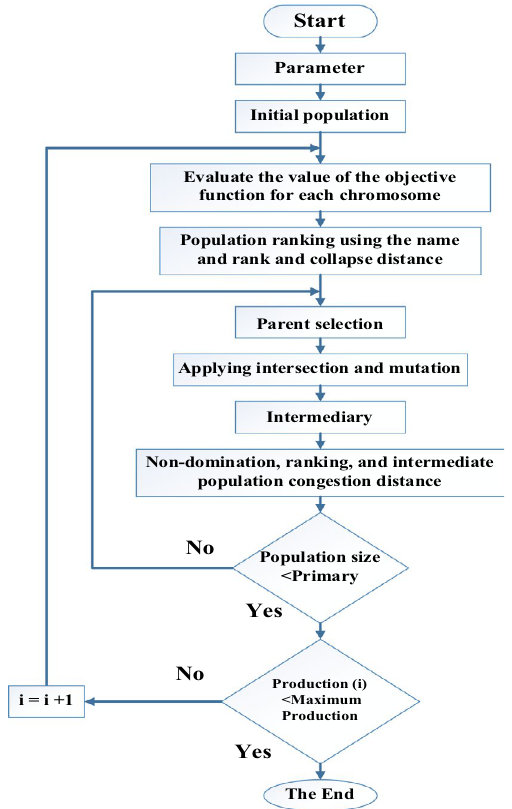
Fig. 3 Proposed flowchart design compatible with NSGA-II algorithm